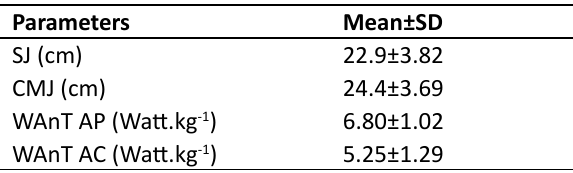
Table 2. The results of anaerobic performance tests (n= 16). Data are reported as mean±SD.